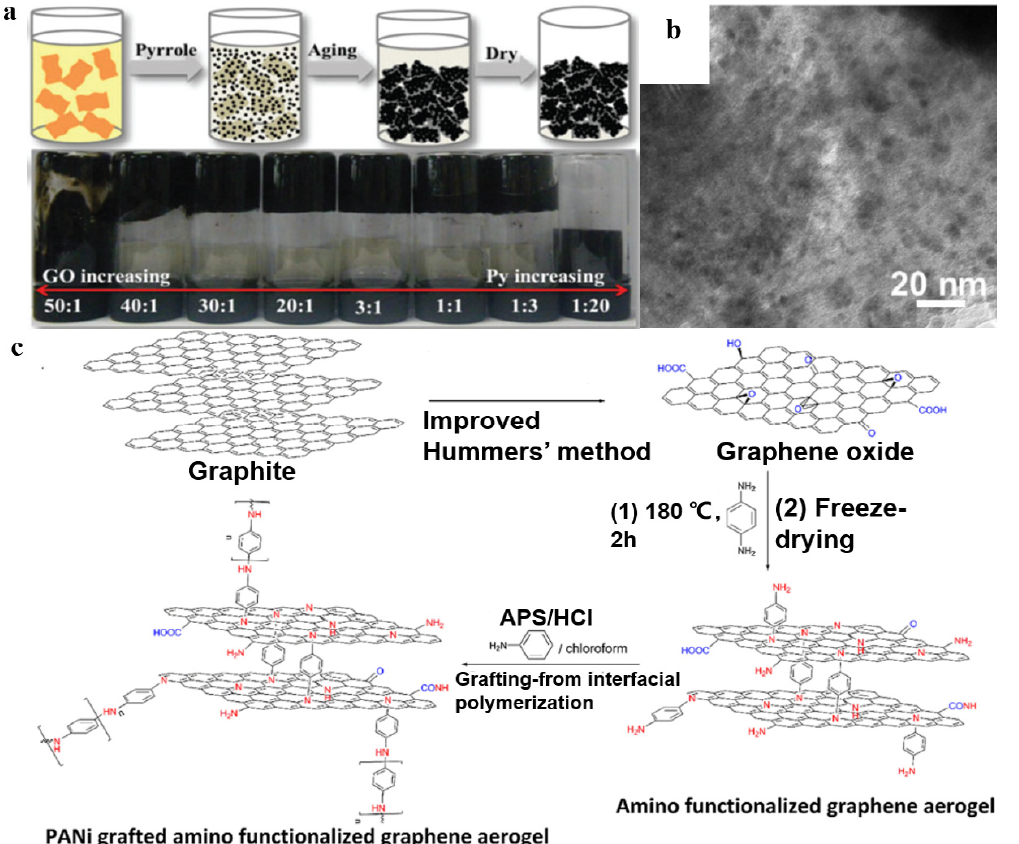
Figure 7. ( a ) Schematic illustration of the formation mechanism of the RGO/PPy aerogel. ( b ) The TEM image of RGO/PPy aerogel. Reproduced with permission from [78]. ( c ) Schematic procedure for synthesis of amino functionalized graphene aerogel grafted with polyaniline nanofibers. Reproduced with permission from [79].